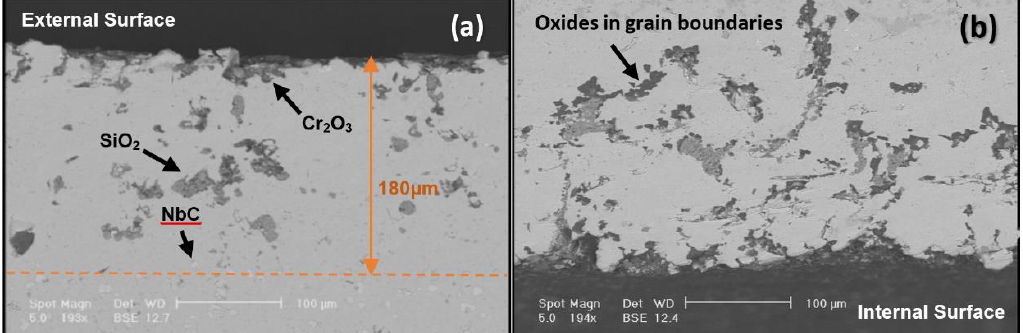
Figure 3. BSE micrograph of Tube A from ( a ) oxides and chrome-depleted zones near the external surface and ( b ) oxides and chrome-depleted zones near the internal surface of the tube.